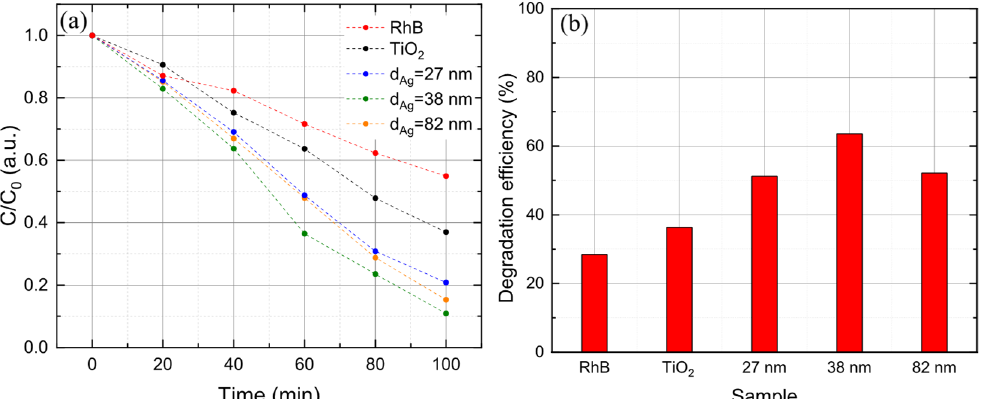
Figure 6. The photodegradation of RhB under UV-C light irradiation by using an AgNP/TiO 2 as a photocatalyst with different NP parameters. ( a ) the kinetics of the photodegradation process and ( b ) the degradation efficiency ( D efi ) of RhB after 60 min of irradiation.